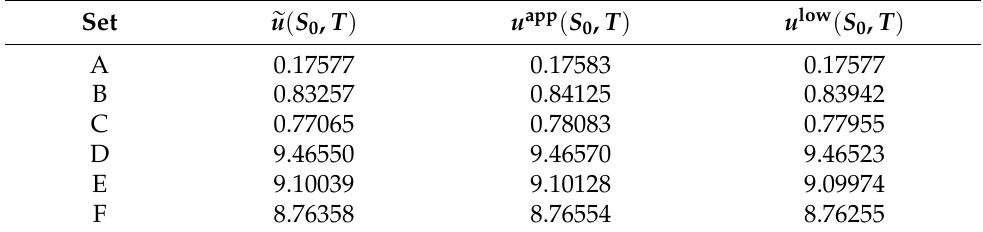
Table 1. Reference values r u p S 0 , T q , u app p S 0 , T q , u low p S 0 , T q for European basket put option.